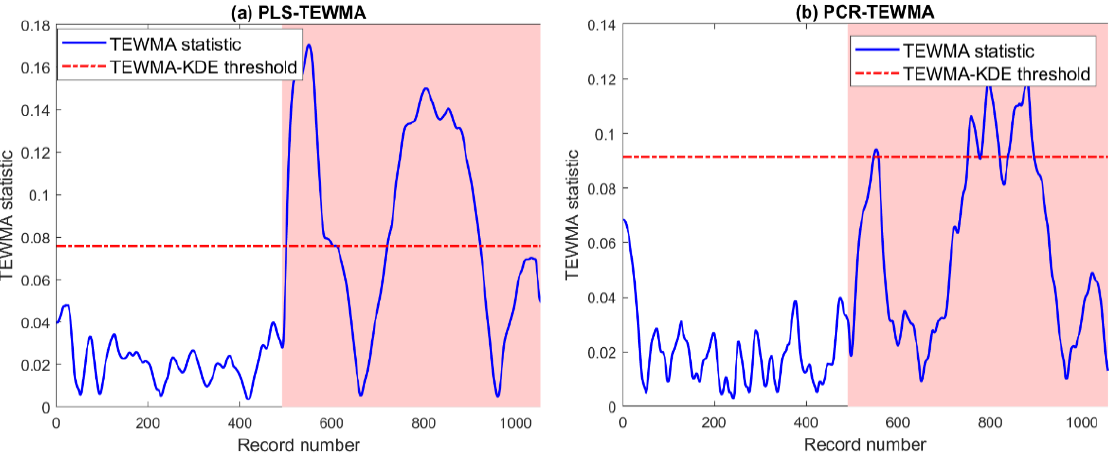
Figure 16. Detection results of ( a ) PLS- and ( b ) PCR-based TEWMA charts in the presence of two short-circuited modules. Table 6. Results of PLS- and PCR-based TEWMA charts under two modules short-circuited.